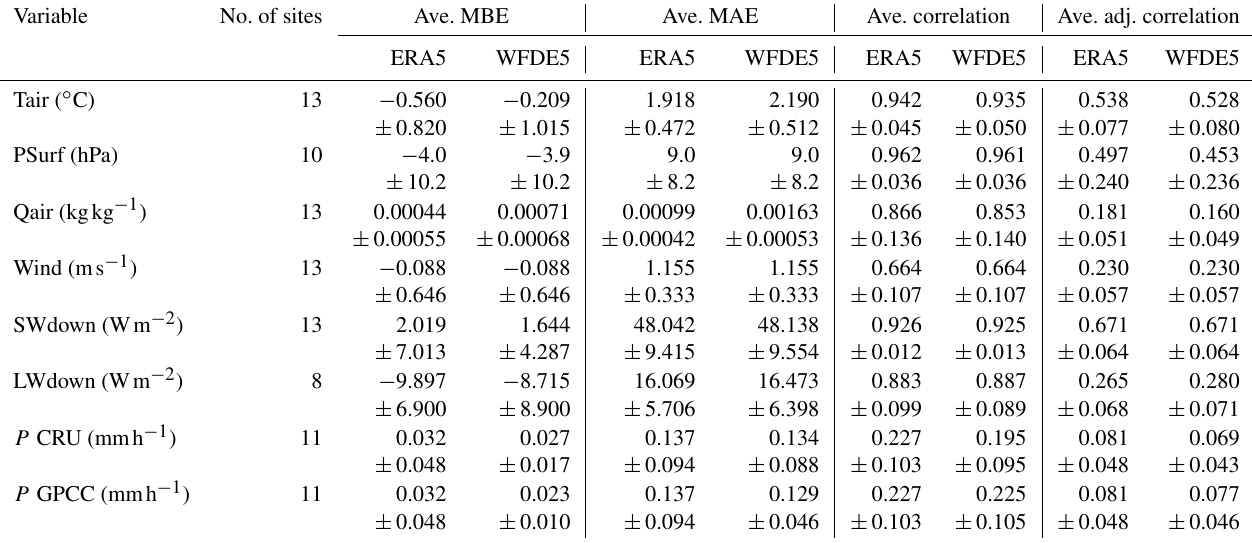
Table A17. Average metrics across all 13 FLUXNET2015 sites ± 95% confidence intervals of the means for ERA5 versus FN2015 and WFDE5 versus FN2015 at hourly time steps (see Tables A1–A8).